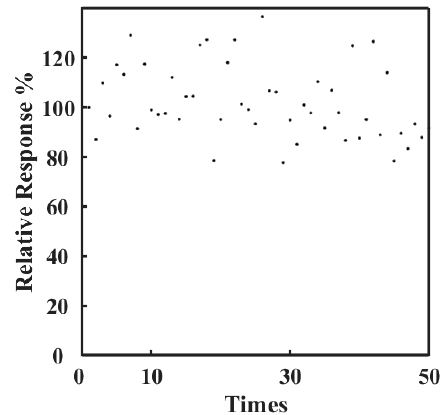
Figure 5. Stability of the tongue depressor amperometric sensors for glucose (phosphate buffer: 180 μ L, droplet of glucose of 50 mM: 20 μ L). Relative response (%): Normalizing the current reponse for the detection of glucose to the initial response.